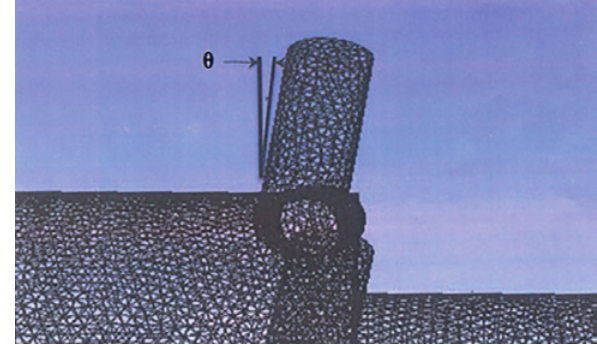
Figure 13. A schematic of the axial angle ( θ ) of an inlet nozzle